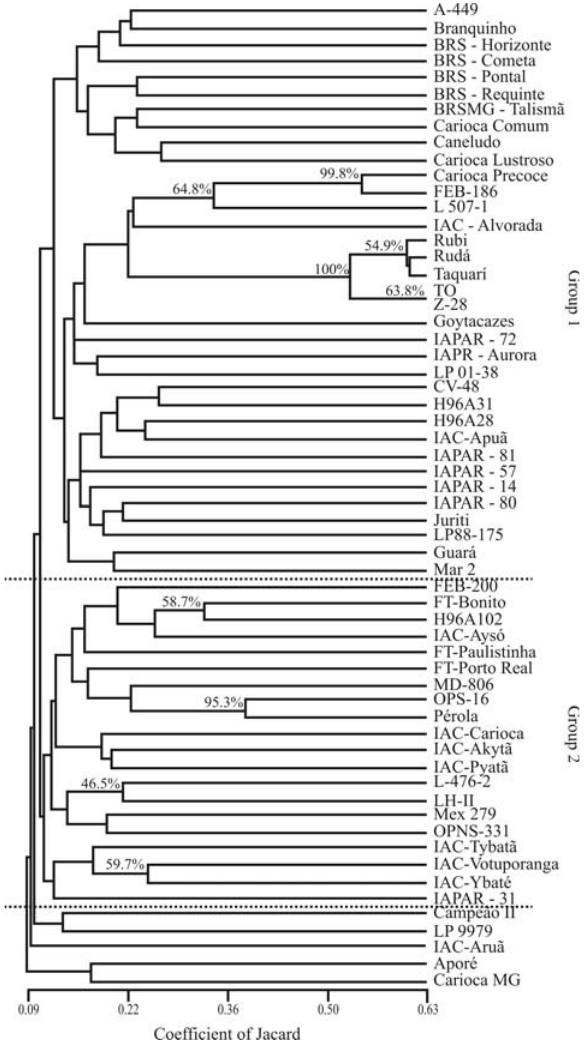
Figure 3 - UPGMA dendrogram for the 60 carioca common beans based on AFLP data. Genetic similarity values were calculated using Jaccards